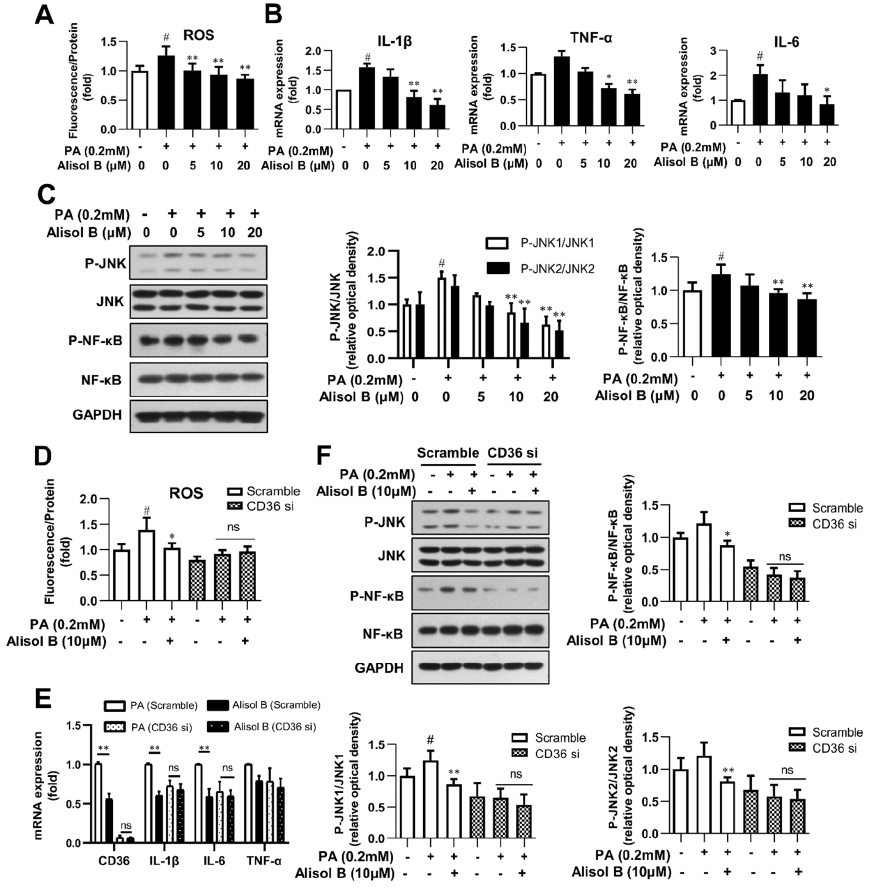
Figure 5. Alisol B inhibited oxidative stress and inflammation in primary hepatocytes in a CD36-dependent manner . Mouse primary hepatocytes were incubated with indicated concentration of Alisol B under PA (0.2 mM)-stimulated conditions. ( A ) Cellular ROS level; ( B ) the mRNA levels of IL-1 β , IL-6, and TNF- α ; and ( C ) JNK1/2 and NF- κ B phosphorylation were detected. ( D – F ) Primary hepatocytes were pretreated with CD36 siRNA for 24 h and then treated with Alisol B (10 μ M) under PA-induced conditions. ( D ) Cellular ROS; ( E ) the mRNA levels of IL-1 β , IL-6, and TNF- α ; and ( F ) JNK1/2 and NF- κ B phosphorylation were detected. Data are expressed as mean ± SD, n = 5 for all of the groups, except for n = 6 in Figure ( F ). # p < 0.05 compared with the normal control group; * p < 0.05, ** p < 0.01 compared with the PA-induced group.